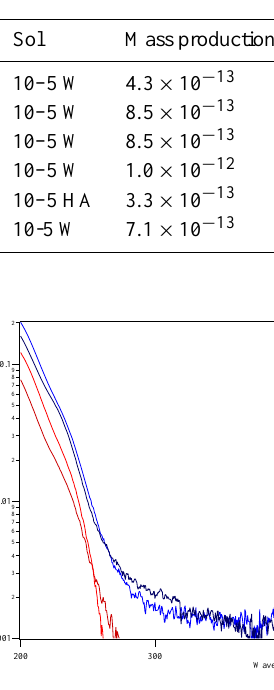
Fig. 2. Results of two iodine oxide particle (IOP) production ex- periments, showing the spectrophotometric spectra of 10 − 5 M IO − solutions in the presence of O 3 (experiment 4) and without O 3 (ex- periment 2). Blue lines represent the UV-VIS spectra at the end of the experiment while the red lines show initial conditions (fresh solution). IOPs were produced in both experiments, indicated by Fig. 1. Schematic diagram of the photochemical flow reactor set the increased absorbance in the range 270–400nm where I − up to study the stability/reactivity of IO − in ice. The solid line 3 have absorbance represents the gas flow pattern, the dashed line shows the chilled methanol circulation.